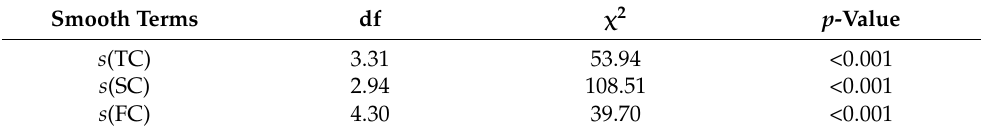
Table 2. Approximate significance of smooth